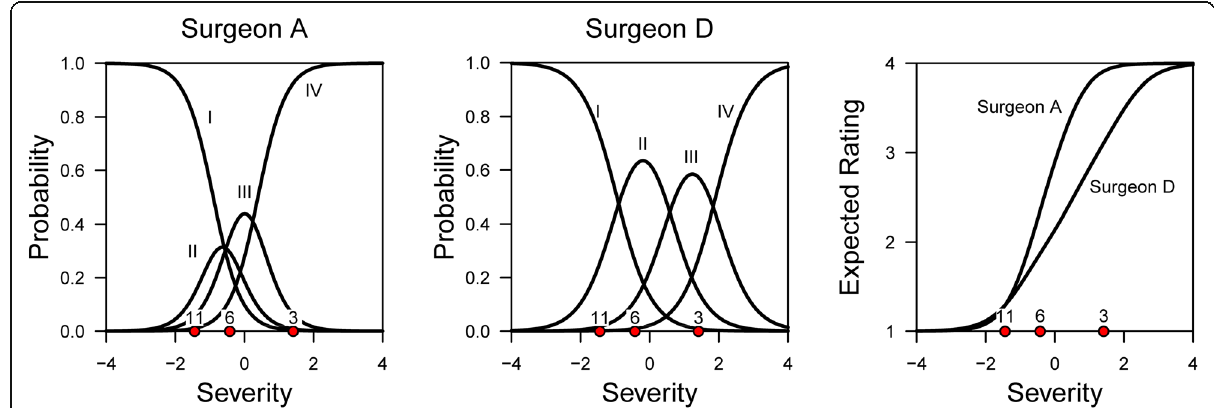
Fig. 1 Graded Response Model tracelines depicting two orthopedic surgeons ’ responses in classifying hip fracture severity. Note: Posterior mean severity locations of three patients are superimposed. Plot recreated using published data